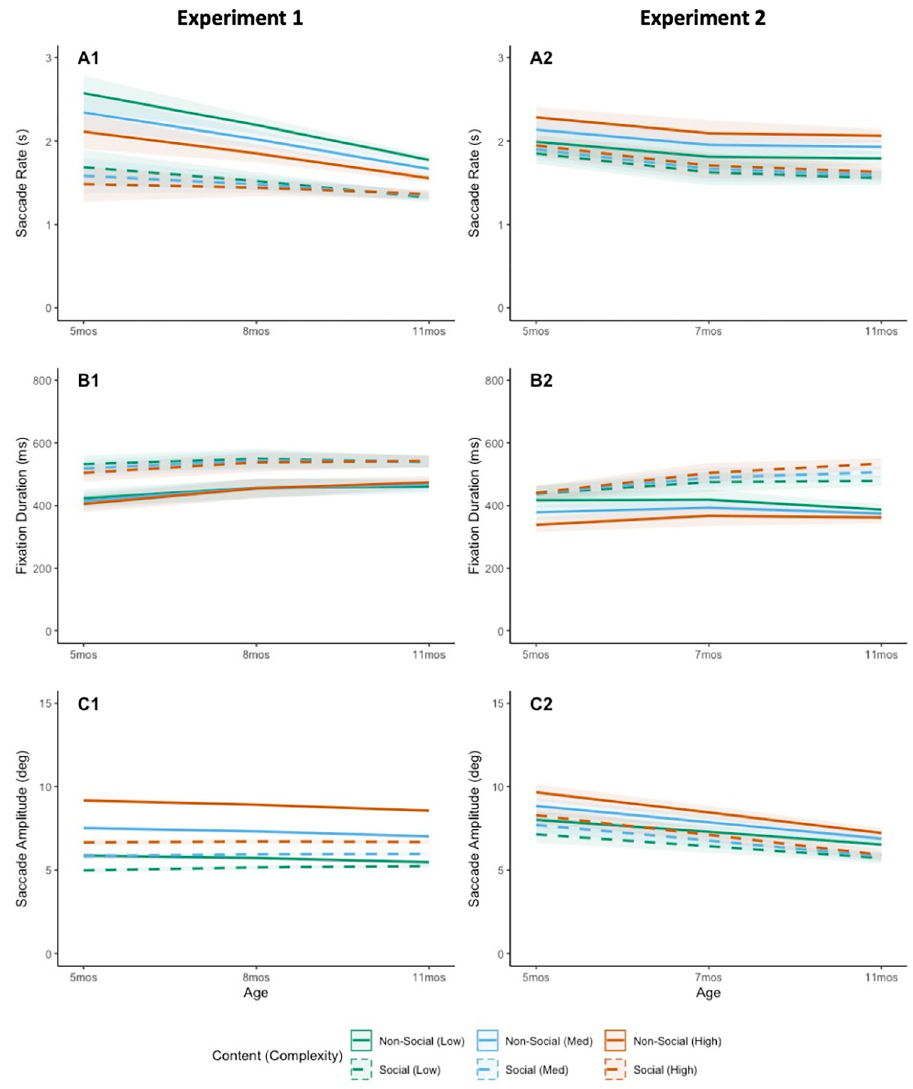
Fig 2. Fitted model estimates by condition for Experiment 1 (left) and Experiment 2 (right). Measures include average saccade rate (A), average fixation duration (B), and average saccade amplitude (C). Shading indicates 95% confidence